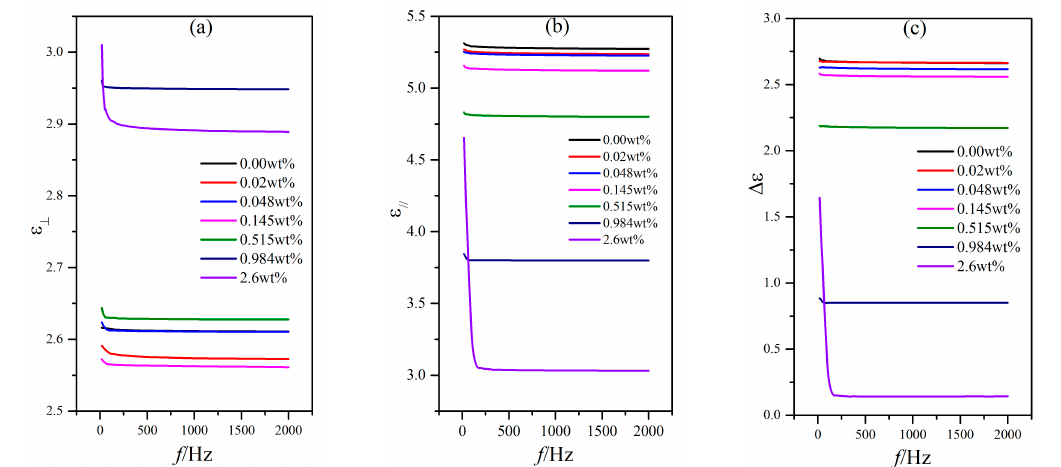
Figure 8. Dependence of the dielectric constants ( a ) ε ⊥ ; ( b ) ε // and the dielectric anisotropy ( c ) Δ ε on the frequency for the LC material MAT-09-1284 doped with γ -Fe 2 O 3 nanoparticles of different concentrations.